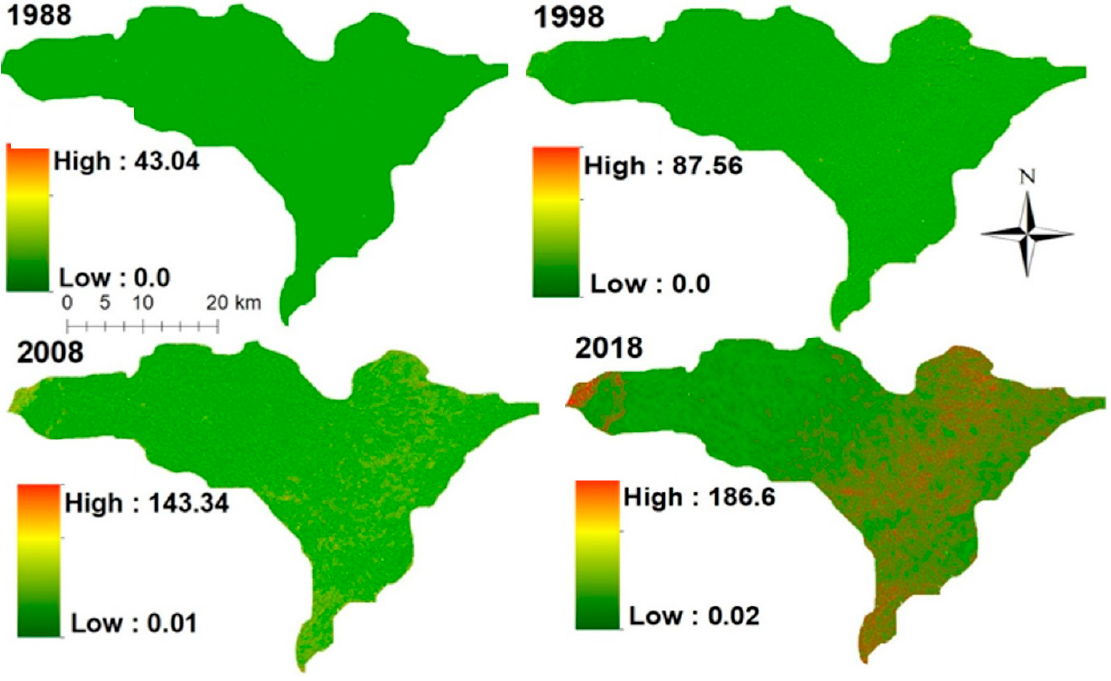
Remote Sens. 2020 , 12 , x FOR PEER REVIEW Figure 5. Spatial distribution of soil erosion in 1988, 1998, 2008, and 2018. Figure 5. Spatial distribution of soil erosion in 1988, 1998, 2008, and 2018.